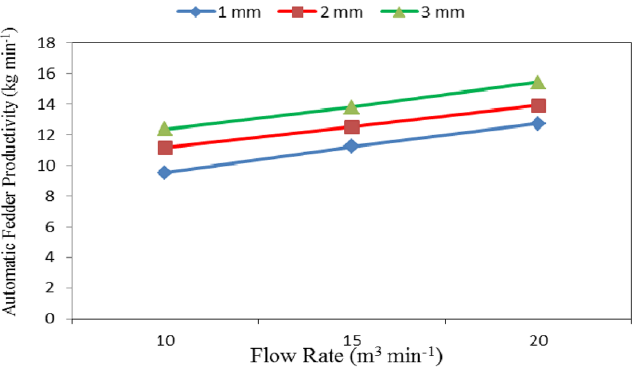
Figure 5. Automatic feeder productivity at different feed pellet sizes and air flow rates.